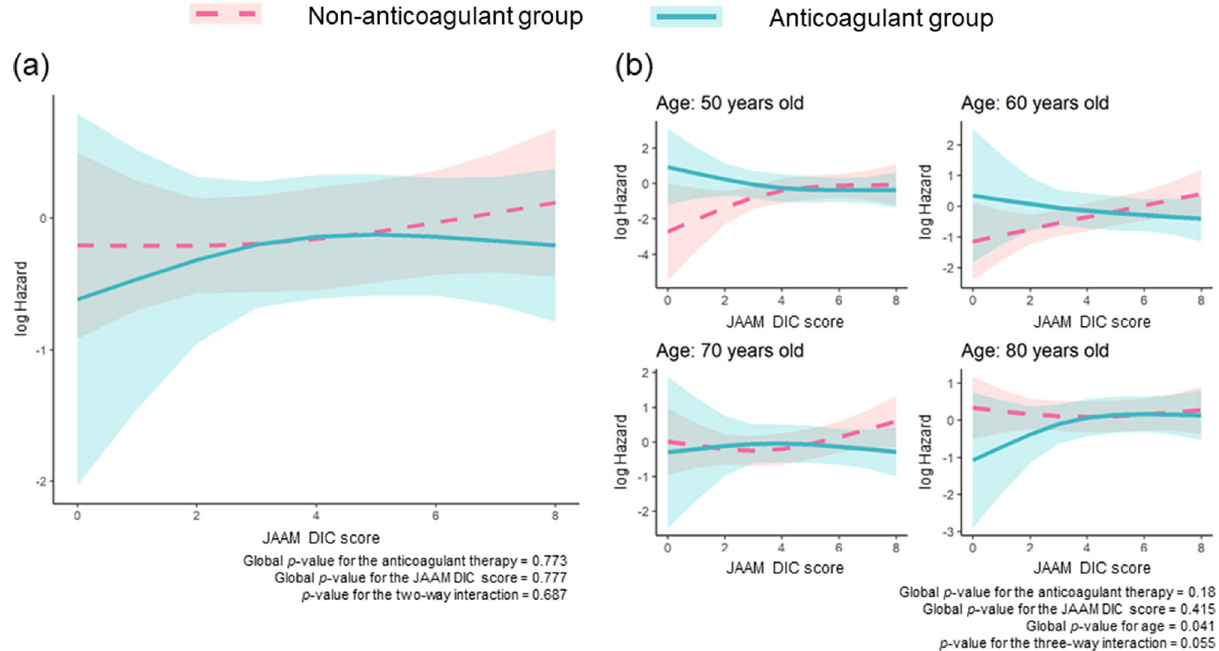
Figure 3. Regression line of hospital mortality of each treatment group estimated by the Cox proportional hazard regression model. ( a ) Two-way interaction term between the treatment and JAAM DIC score. ( b ) Three-way interaction term among anticoagulant therapy, the JAAM DIC score, and age. The lines indicate estimated log-transformed relative hazards, and the shaded areas represent 95% confidence intervals. The solid blue line represents patients in the anticoagulant group, and the dotted red line represents those in the non-anticoagulant group. JAAM, Japanese Association for Acute Medicine; DIC, disseminated intravascular coagulation. Anticoagulant therapy was defined as the administration of antithrombin, recombinant human thrombomodulin, or their combination in the present